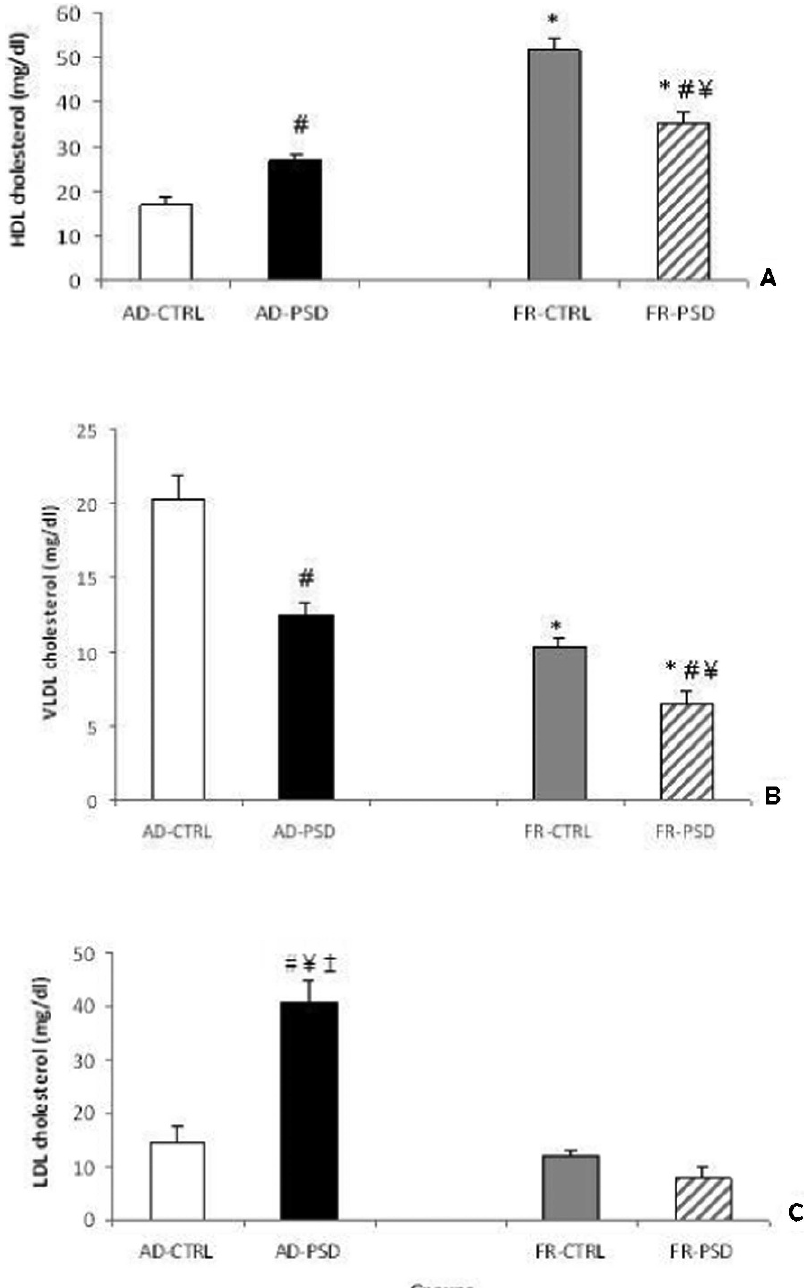
Figure 2 - Concentrations of HDL (panel A), VLDL (panel B) and LDL cholesterol (panel C) in male ad libitum (AD)-fed or food-restricted (FR) rats subjected to normal sleep (CTRL) or paradoxical sleep deprivation (PSD). Data are expressed as the means ¡ SEM. *Significantly different from the AD-CTRL group, ¥ Significantly different from the AD-PSD group, { Significantly different from the FR- CTRL group and # Significantly different from the respective